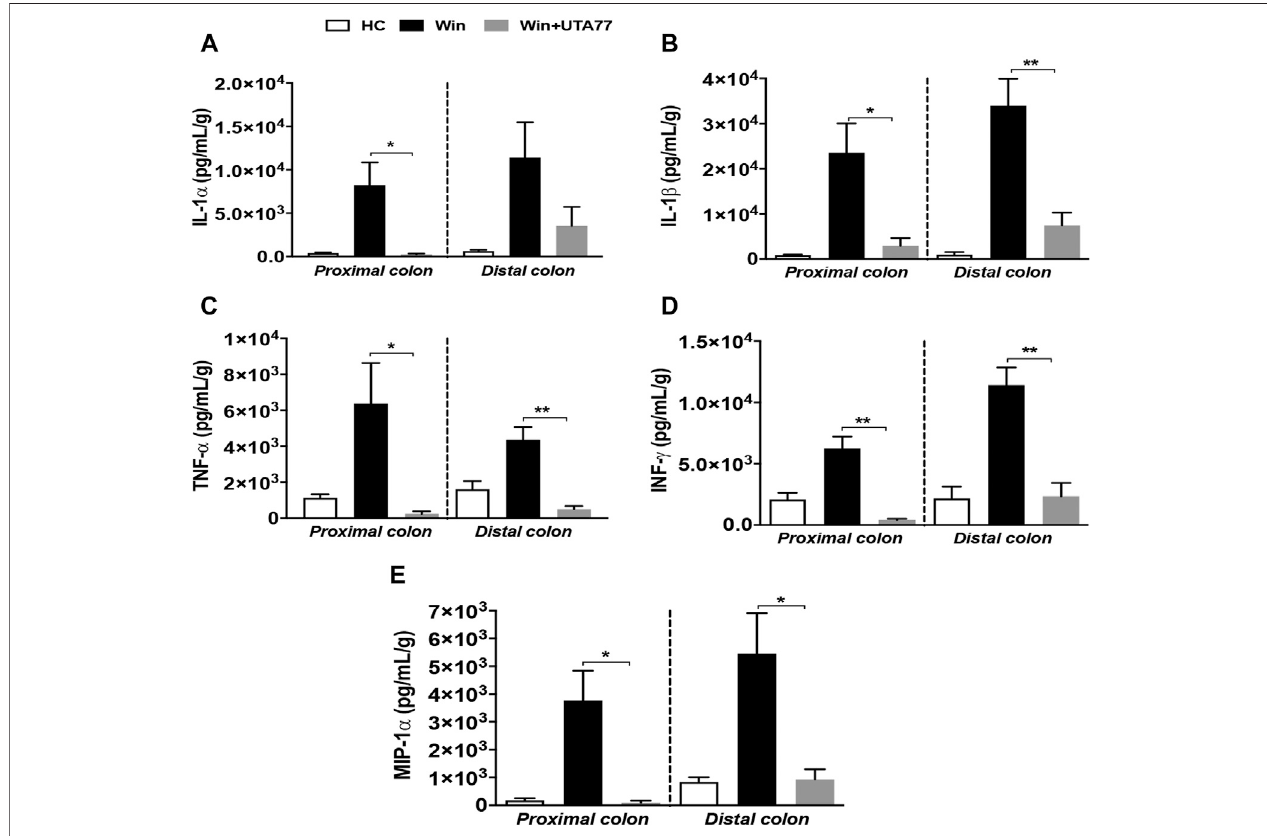
FIGURE 10 | Effect ofUTA77 on the level of proin fl ammatory cytokines and chemokines in colonic tissue explants ofWinnie mice. Tissue levels of (A) IL-1 α , (B) IL- 1 β , (C) TNF- α , (D) INF- γ , and (E) MIP-1 α in PC and DC were quanti fi ed by Bio-Plex assay. Data expressed as mean ± SEM ( n (cid:1) 3/group) and statistical signi fi cance evaluated by one-way ANOVA followed by Tukey ’ s posttest where *p < 0.05 and **p < 0.01.